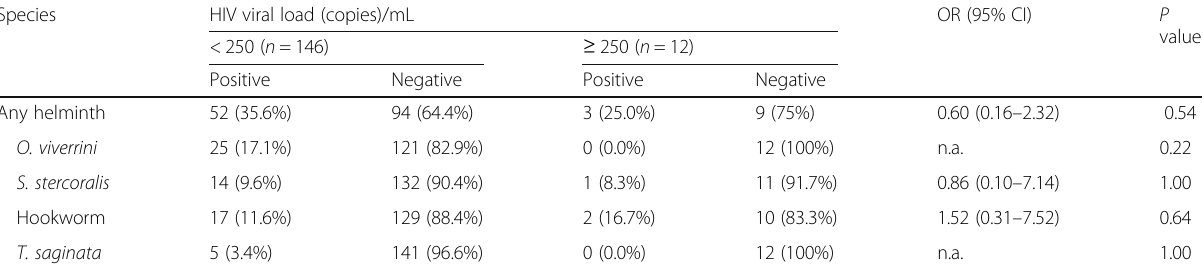
Table 5 Association of intestinal helminths with HIV viral load in HIV-infected patients ( n = 158; among the participants who were screened for helminths via stool samples, only 158 had available HIV viral load data)